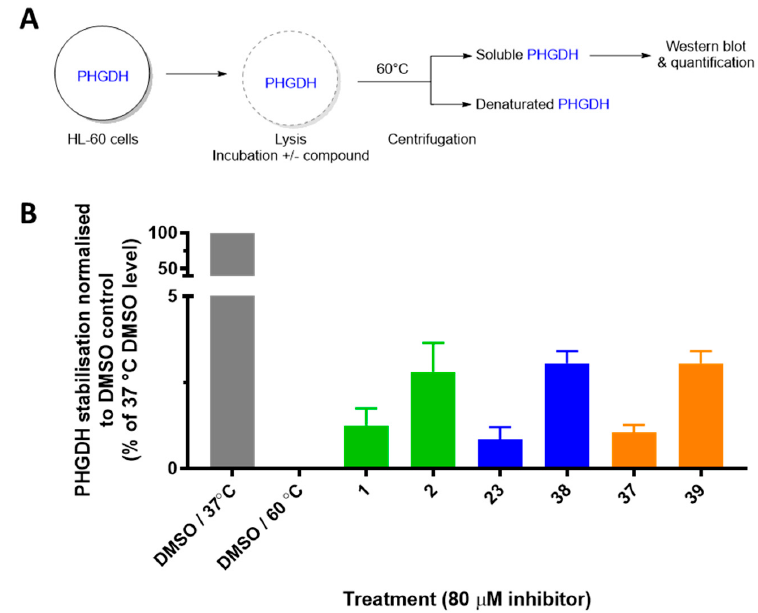
Figure 4. Cellular thermal shift assay (CETSA) for the most promising inhibitors in HL ‐ 60 cells. ( A ) Schematic overview of CETSA experiment. ( B ) Quantification of thermostable PHGDH normalized to the respective control at 37 °C. Results represent the average of two independent experiments.